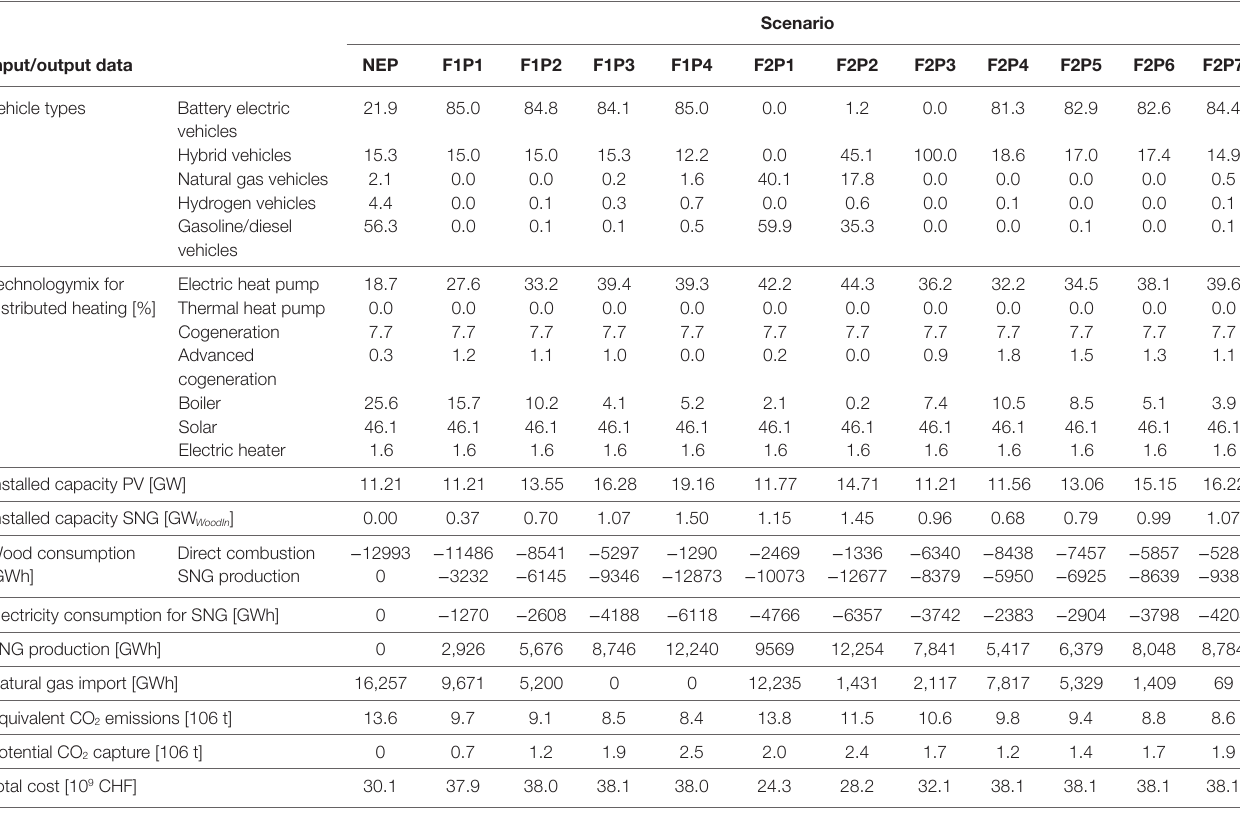
TaBle 8 | Input and output data for the NEP scenario and the highlighted scenarios in Figures 10 and 11 for 2050.